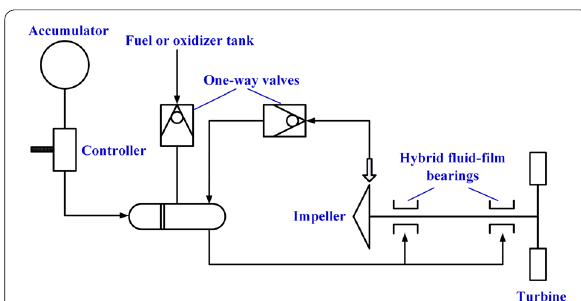
Figure 9 Application scheme of hybrid fluid-film bearings by adding an